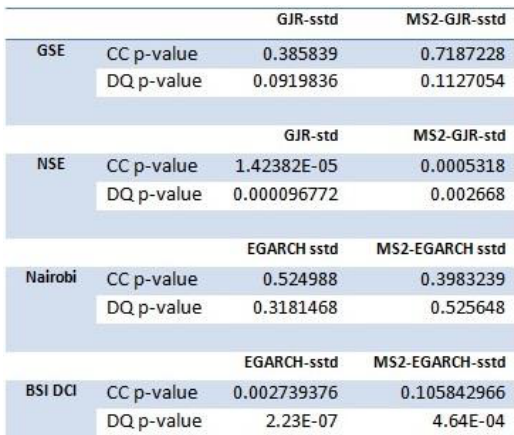
Figure 4. Conditional Volatility of the Index Returns of the Four Sub-Saharan Equities